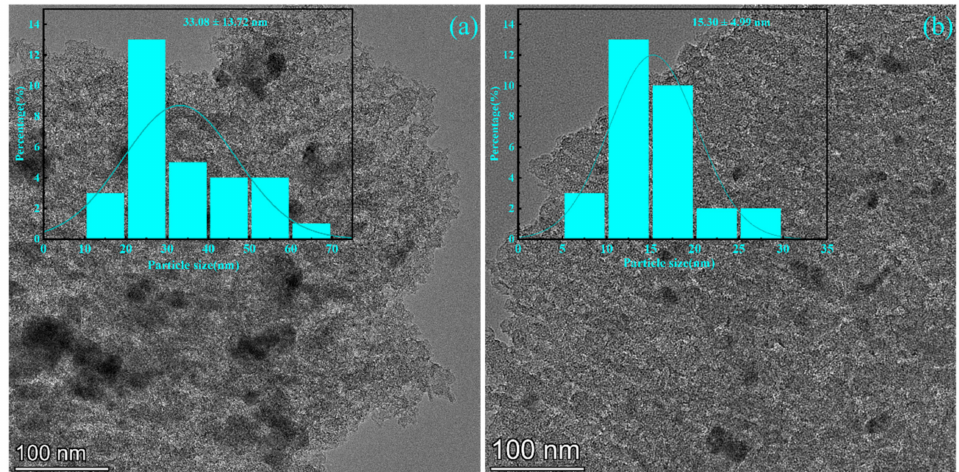
Figure 5. ( a ) TEM image and particle size distribution of the catalyst prepared with water as the solvent; ( b ) TEM image and particle size distribution of the catalyst prepared with mixed solvent